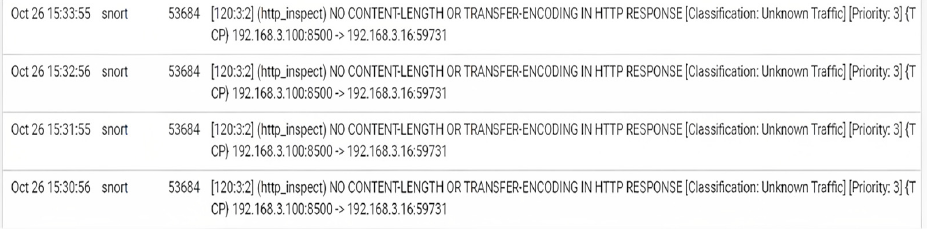
Figure 12. Firewall logs during the